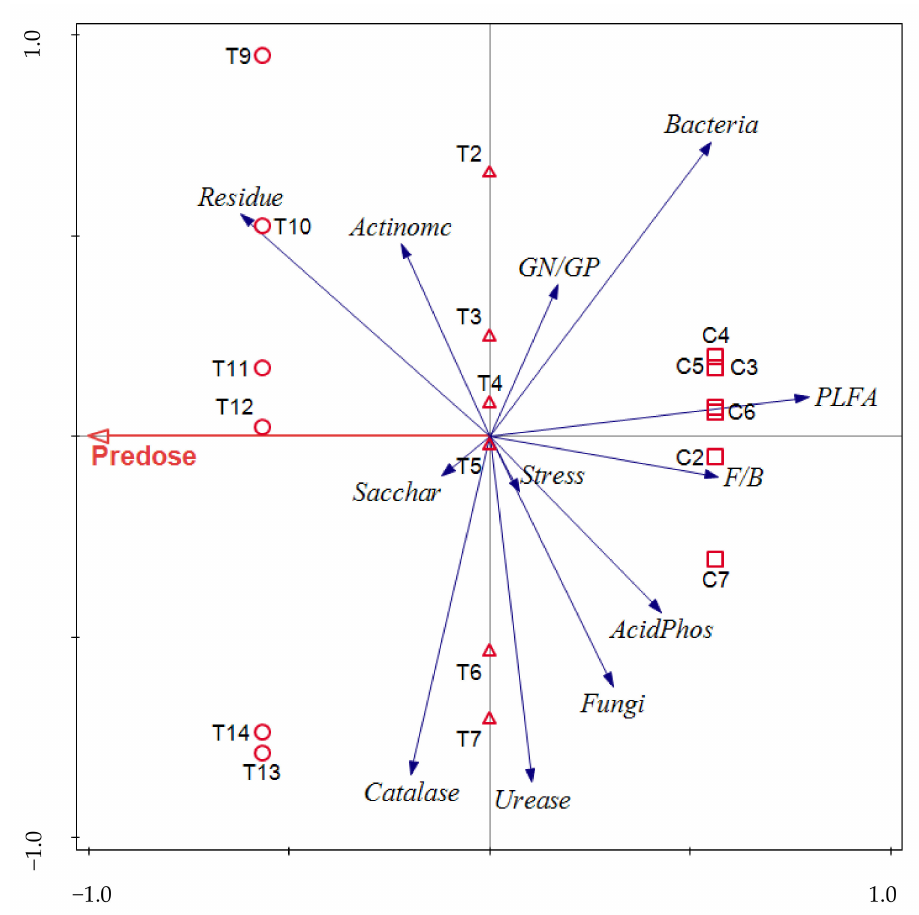
Figure 5. RDA analysis was carried out to determine the effects of the initial stage of fomesafen application on microbial community structure. (cid:3) : Control; (cid:52) : the recommended usage; the recommended